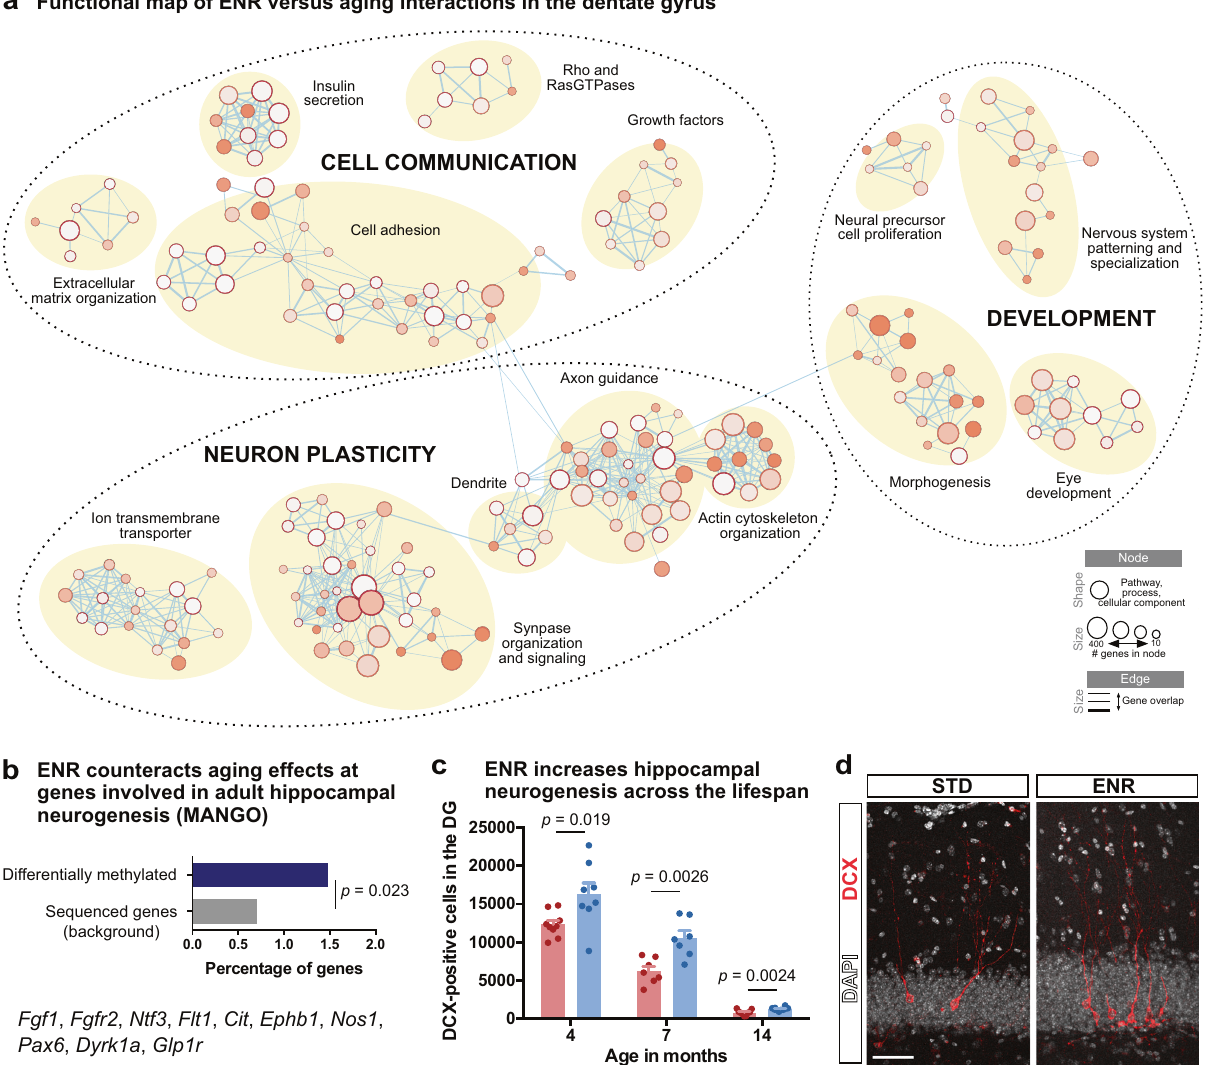
Fig. 4 Functional enrichment connects environmentally sensitive age-related DNA methylation changes with neuronal plasticity and adult hippocampal neurogenesis. a Integrated map of GO terms, SynGO terms, Reactome pathways, and “ WikiPathway ” terms enriched among the 676 ENR- induced differentially methylated genes that counteract aging effects (signi fi cantly enriched terms with q < 0.05). Three main functional clusters were identi fi ed (dashed circles), each containing several groups of highly connected terms (yellow circles). Legend indicates node and edge sizes. b Genes functionally involved in hippocampal neurogenesis are enriched among differentially methylated genes at which ENR counteracts age effects ( p -value from a one-sided hypergeometric test). c Mice housed in ENR starting at an age of 6 weeks have signi fi cantly more newborn, doublecortin (DCX)-expressing neurons in the dentate gyrus (DG) at ages 4 months, 7 months, and 14 months compared to STD housed mice. Depicted are individual data points and bars with group means + SEM (4 months: n = 9 STD mice, 8 ENR mice; 7 months: n = 7 mice per group; 14 months: n = 9 STD mice, 10 ENR mice). Depicted p -values are from a two-sided, unpaired t -test. d Representative image of fl uorescent staining to detect newborn neurons in STD and ENR mice. Fluorescent stainings were reproduced for all samples presented in panel ( c ). Scale bar: 50 µ